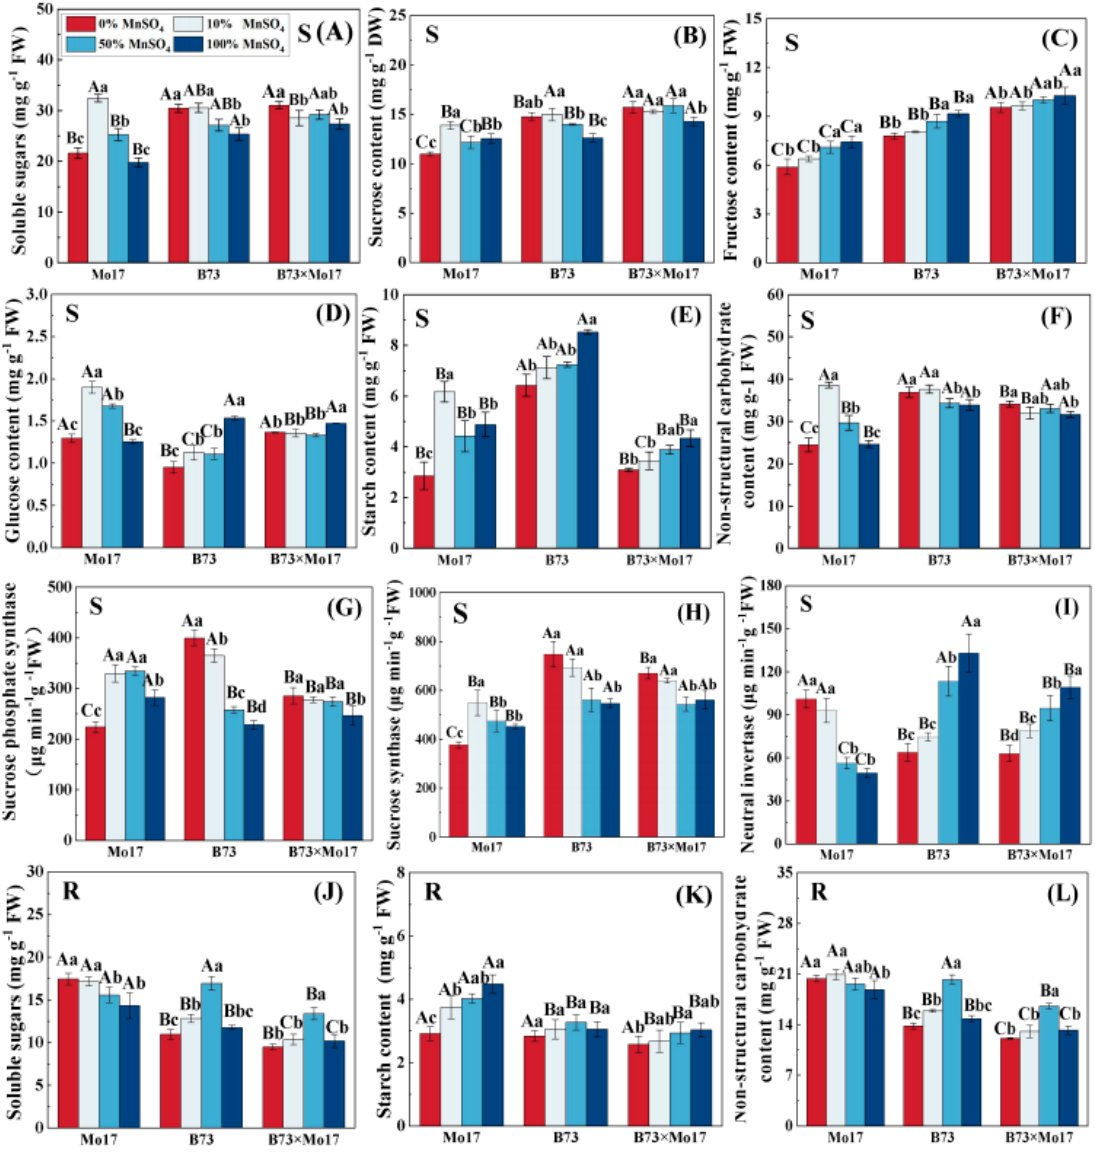
Figure 5. Effect of Mn deficiency on soluble carbohydrate content and carbon metabolism-related enzyme activities in maize seedlings. Soluble sugars ( A , J ), sucrose content ( B ), fructose content ( C ), glucose content ( D ), starch content ( E , K ), nonstructural carbohydrate ( F , L ), sucrose phosphate syn-thase ( G ), sucrose synthase ( H ), neutral invertase ( I ). According to the LSD test different capital letters: significant difference between varieties ( p < 0.05); different lowercase letters: significant dif- ference between MnSO 4 treatments ( p < 0.05). S represents leaf-related parameters, R indicates root- related parameters. Data are expressed as the mean of three replicates.